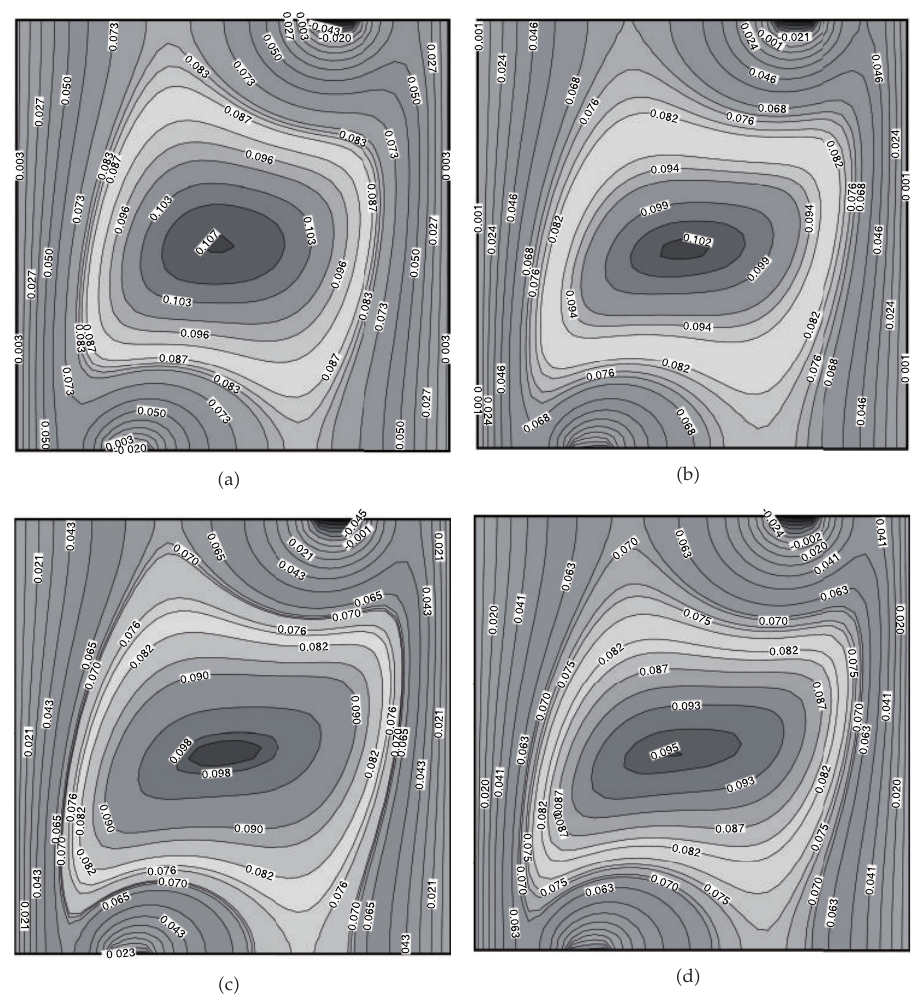
Figure 16: Streamline contours along the left vertical wall while fixing B (cid:8) 1, D/H (cid:8) 0 . 1, a (cid:8) 0 . 1, Ra (cid:8) 100, S C (cid:8) 0 . 1 for (cid:2) a (cid:3) Le (cid:8) 0 . 25, (cid:2) b (cid:3) Le (cid:8) 0 . 5, (cid:2) c (cid:3) Le (cid:8) 0 . 75, (cid:2) d (cid:3) Le (cid:8) 1 . 0.